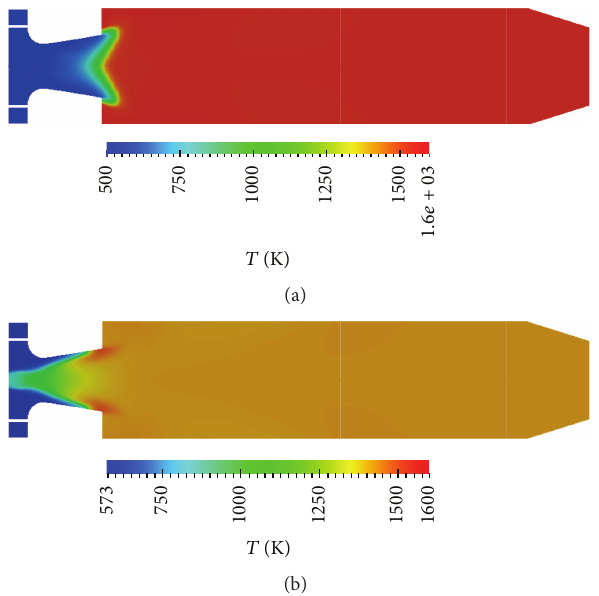
Figure 13: Predicted time-averaged temperature fields in a plane through combustor for (a) NG-FGR0 flame and (b) SG-FGR0 flame.